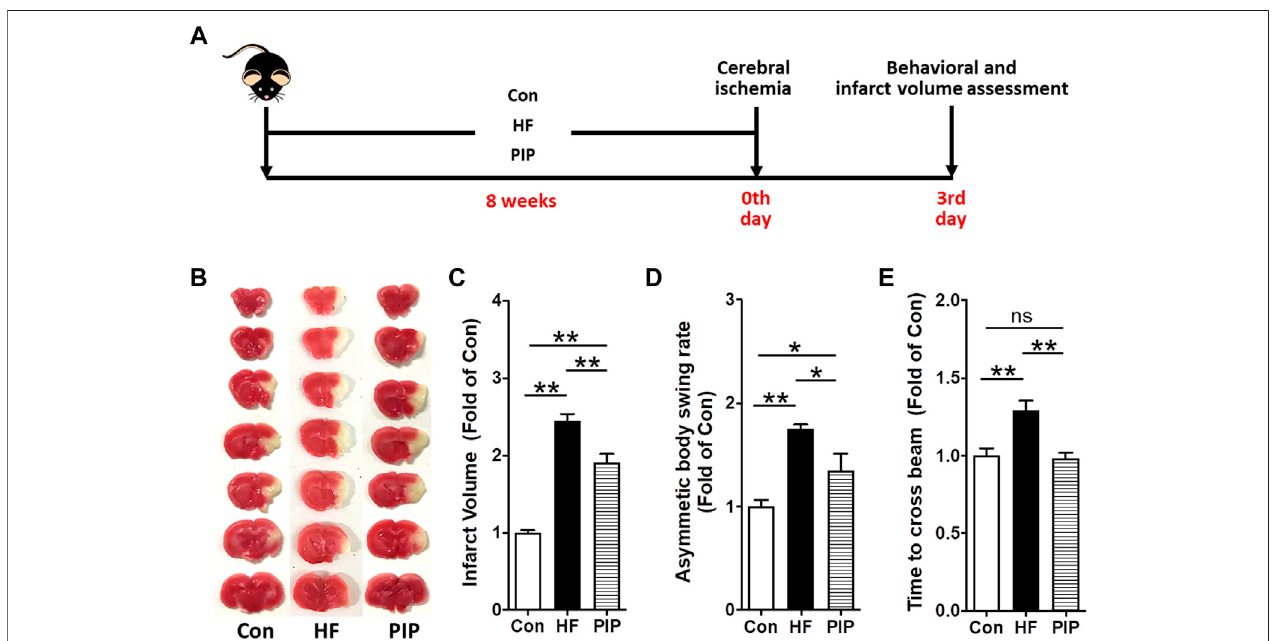
FIGURE 3 | Low-dose Piperlongumine administration protected against cerebral ischemic injury in HFD-fed mice. (A) , Surgical protocols: Male C57BL/6 mice (8 weeks) were randomized into three groups and fed with high-fat rodent chow with or without receiving an intraperitoneal injection of low-does piperlongumine (0.25 mg/kg/d) for 8 weeks. Then the mice were subjected to focal cerebral ischemia by permanent. On day 3 after cerebral ischemia, behavioral test (including Body Asymmetry Test and Beam Test) was performed, and then the cerebral infarct volumes were determined. (B,C) , Images are representative of TTC-stained brain sections (B) andcerebralinfarctvolumes (C) . (D,E) ,Neurobehavioraloutcomes:BodyAsymmetryTest (D) andBeamTest (E) .Throughout,barsrepresentmeans;error bars represent SEM. Values were normalized to Con. * p < 0.05, ** p < 0.01. n (cid:2) 8 per group. Con, control mice; HF, HFD-fed mice; PIP, HFD-fed mice treated with